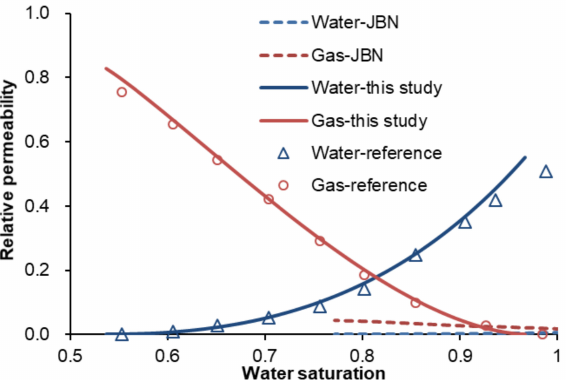
Figure 12. Comparison of the Johnson–Bossler–Naumann (JBN) interpreted versus true relative permeability curves.